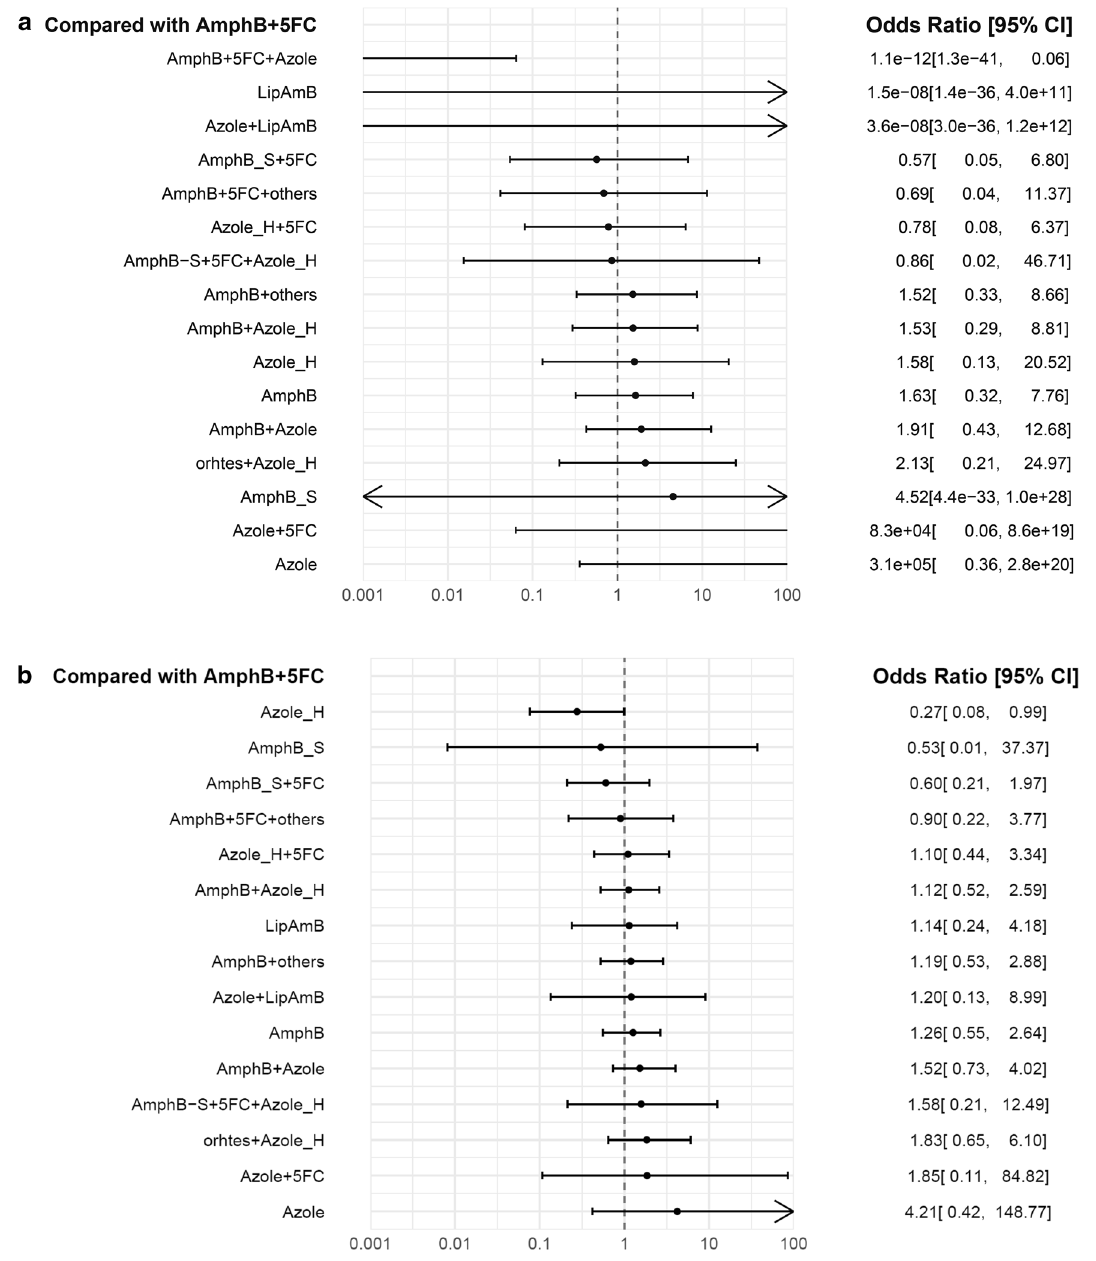
Figure 3. Forest plot of network meta-analysis of two major outcomes for cryptococcal meningitis in HIV patients. ( a ) Forest plot of network meta-analysis of early mortality rate for cryptococcal meningitis in HIV patients. ( b ) Forest plot of network meta-analysis of late mortality rate for cryptococcal meningitis in HIV patients. AmphB, amphotericin B; AmphB_S, short course (only 1 week) amphotericin B; Azole_H, high dose (> 800 mg day); cryptococcal meningitis, CM; fluconazole; 5-FC, flucytosine; human immunodeficiency virus, HIV; LipAmB, liposomal amphotericin B; NMA, network meta-analysis. Notes : the left of the null axis at 1 favor the lower mortality rate and those to the right favor the higher mortality